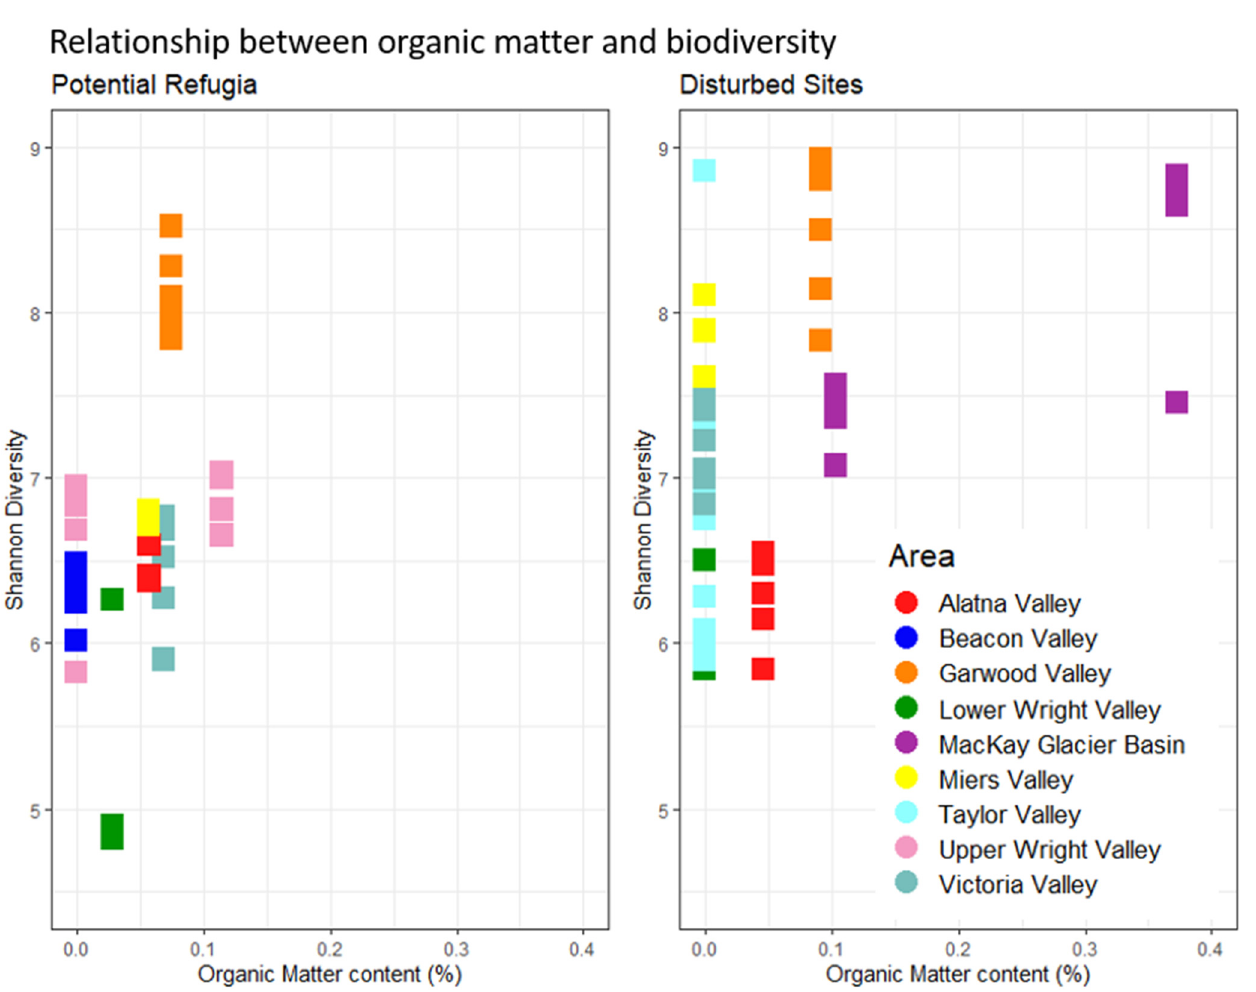
Figure 6. Relationship between organic matter and biodiversity. Individual sample replicates’ Shannon diversity is displayed in relation to the location’s organic matter content. Replicates from the same site share the same organic matter content. Putative refugia sites and disturbed sites are displayed separately. Colors indicate valley basin of sample origin.